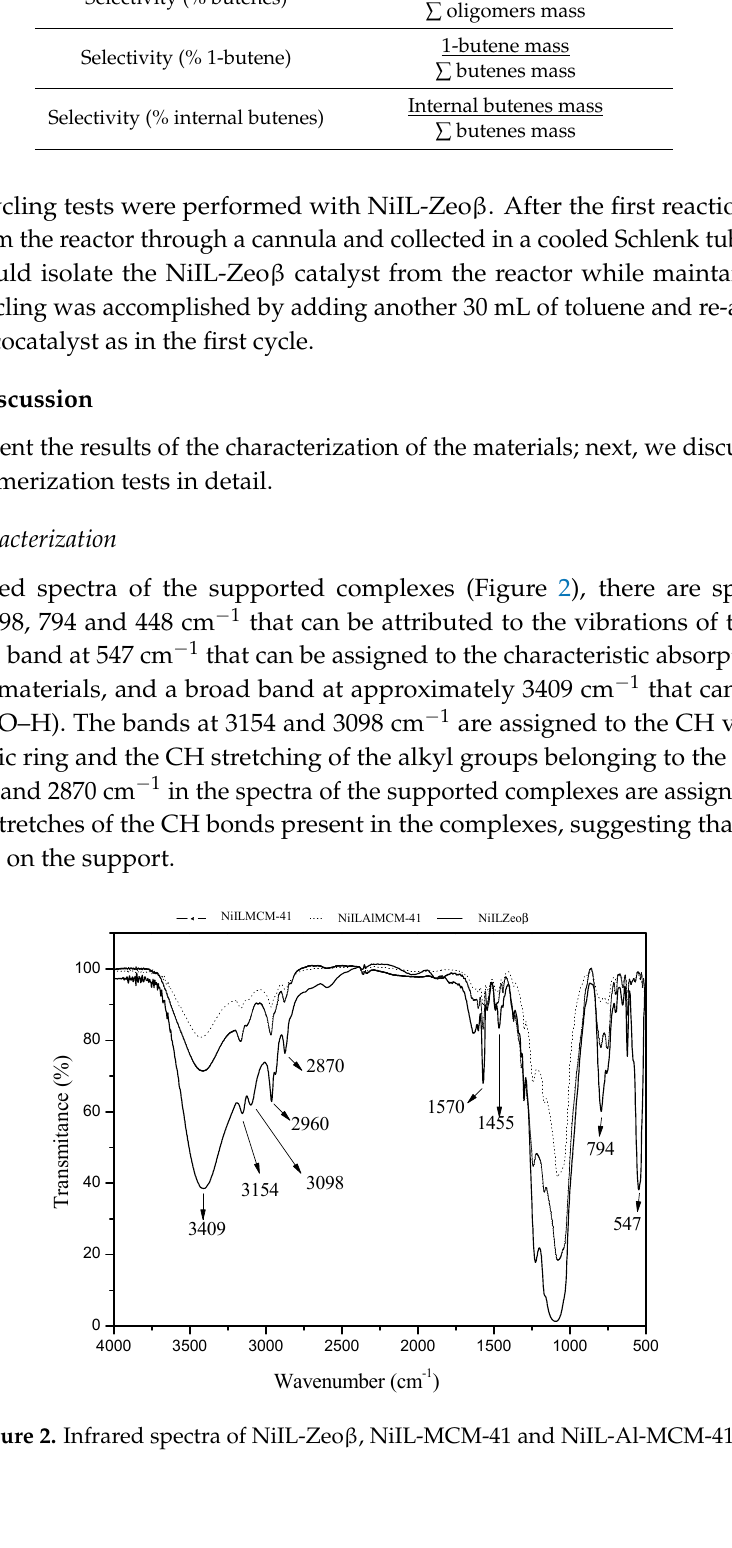
Table 1. Expressions used for calculations of activity and selectivity of the oligomers. Turnover Frequency (TOF) Selectivity (% butenes)